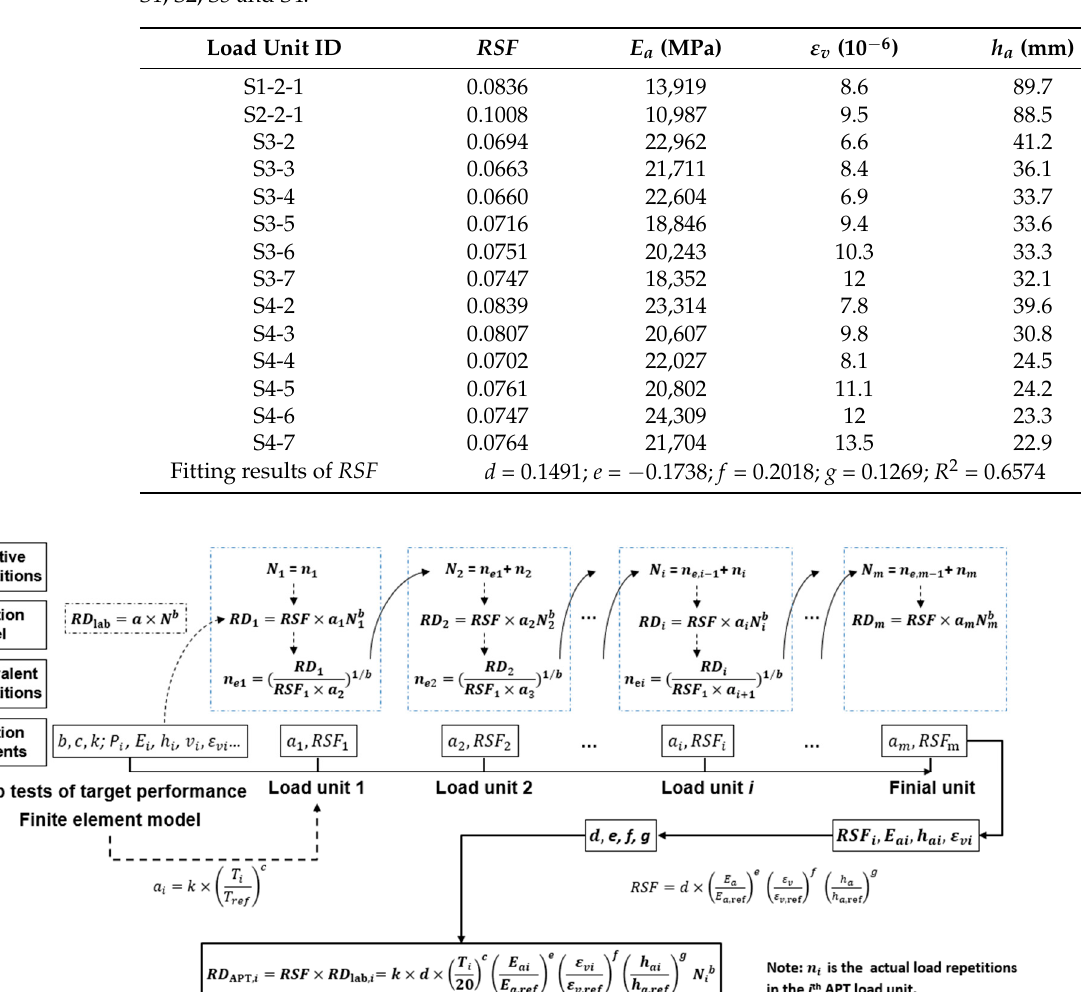
Table 6. Parameter calculation results and RSF calibration results from the consecutive load units of S1, S2, S3 and S4.